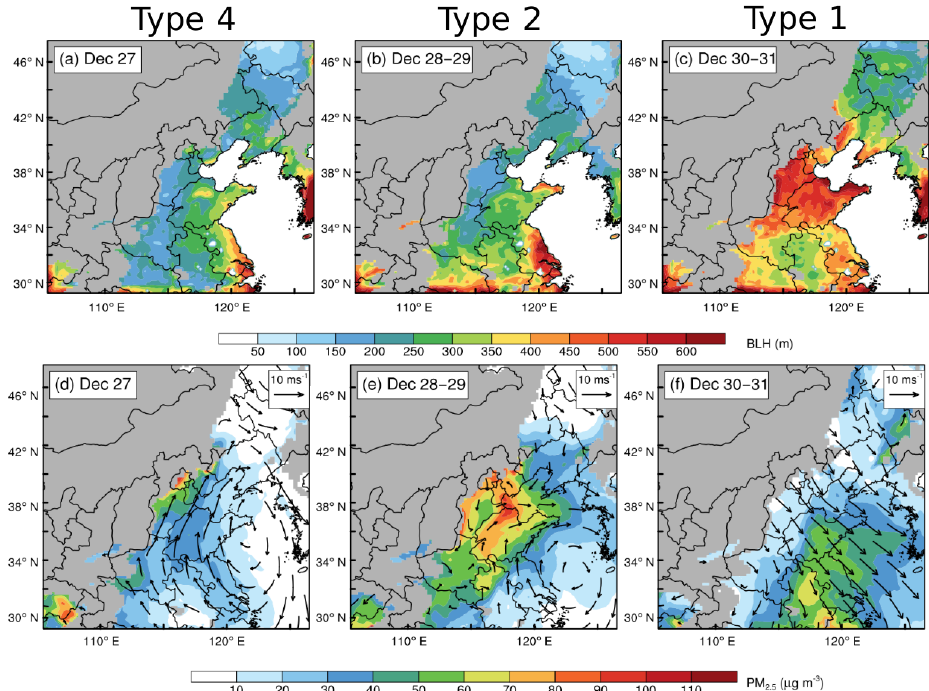
Figure 8. Spatial patterns of simulated (a–c) BLH and (d–f) 900hPa PM 2 . 5 concentration and wind vectors over the plains of BTH from 27 to 31 December in 2017. The mountainous regions are denoted by the grey